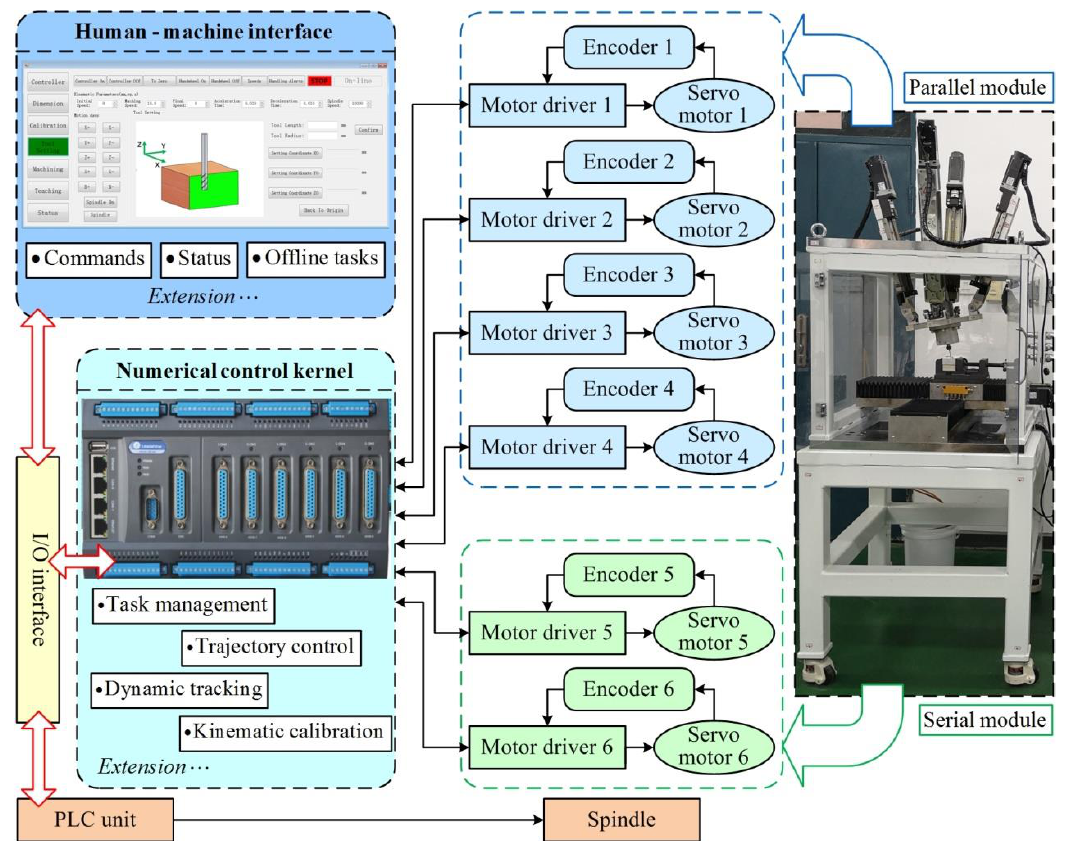
Figure 4. Basic architecture of the developed controlling system.